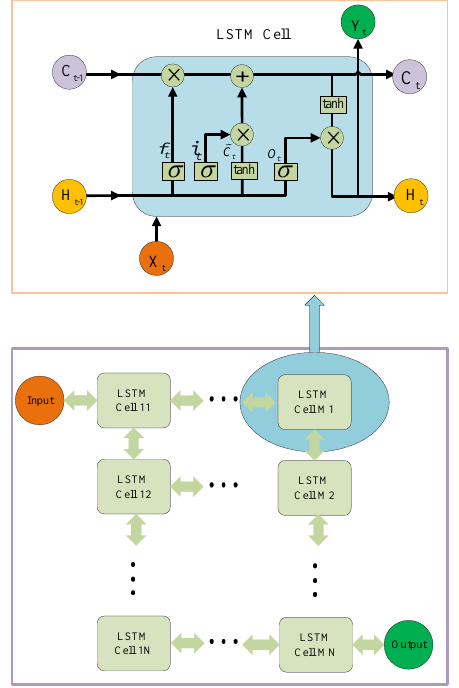
Figure 3. The framework of Long Short-Term Memory (LSTM)